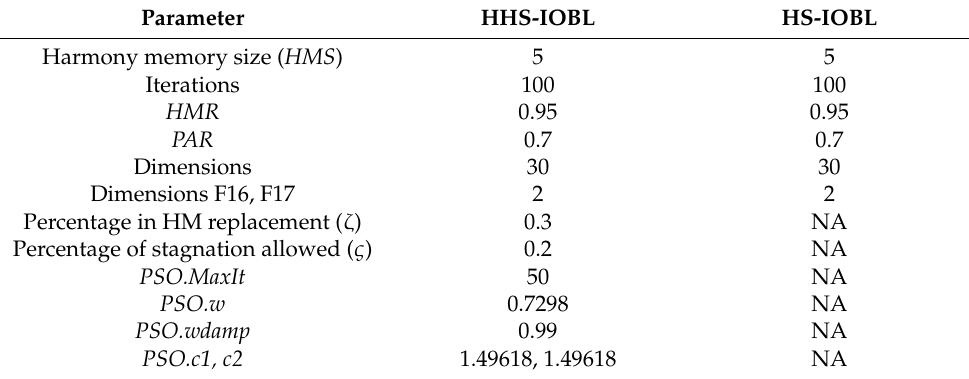
Table 1. Parameters and variables